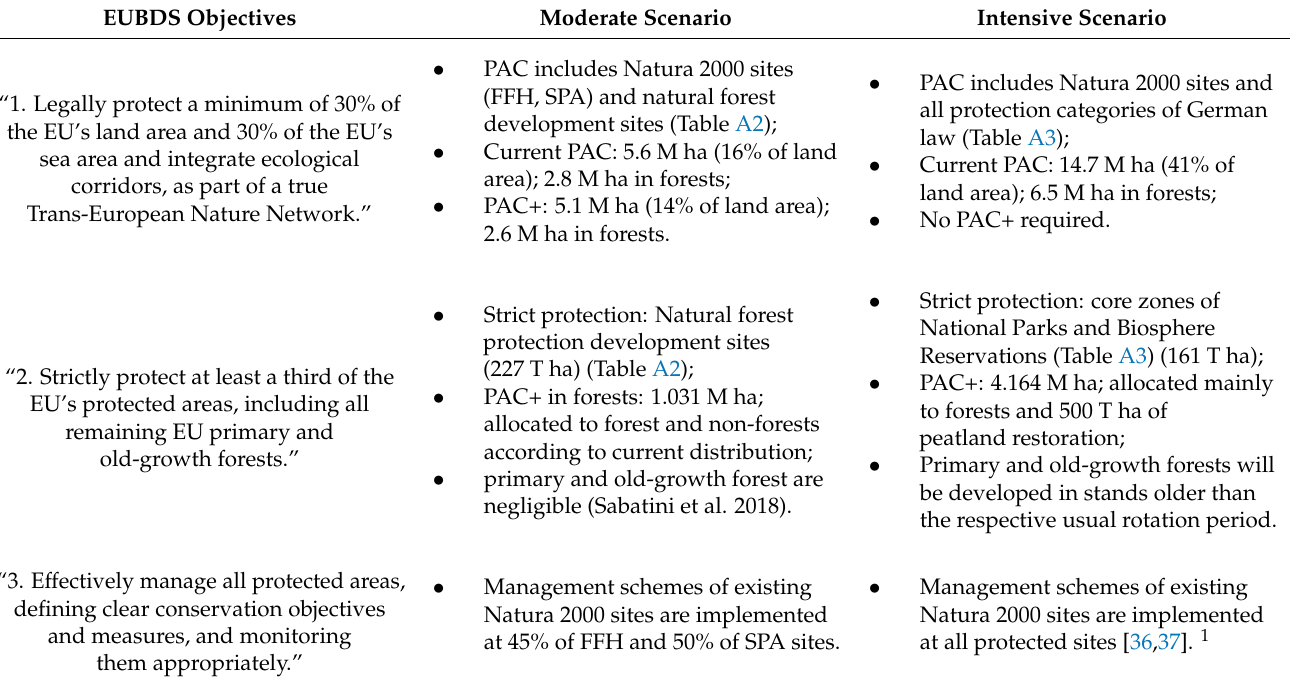
Table 2. Overview of operationalization of EUBDS objectives in an intensive (ISC) and a moderate (MSC) implementation scenario for Germany [authors’